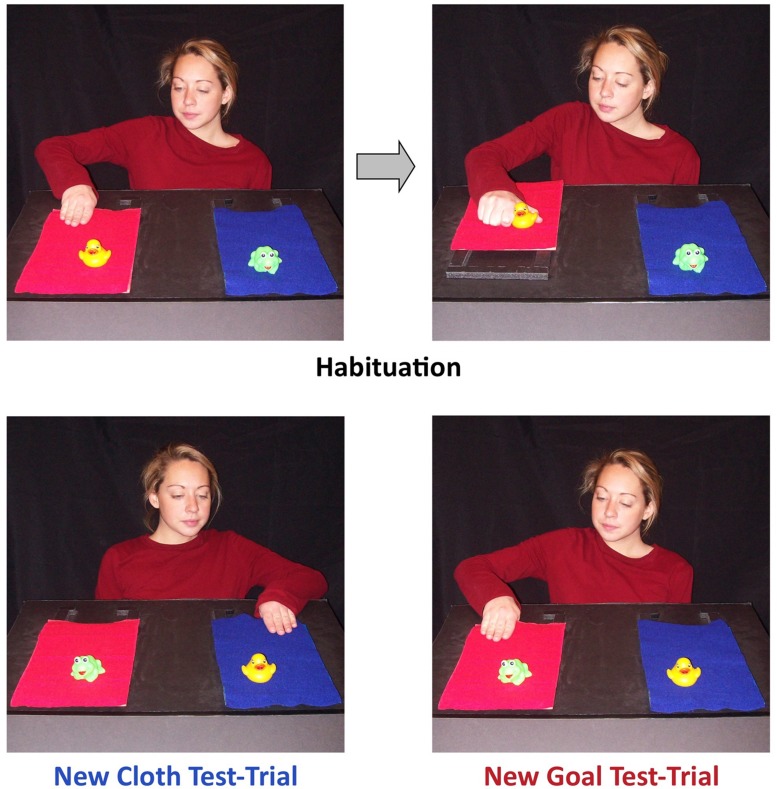
Habituation paradigm used in Sommerville and Woodward (2005) and current experiments.